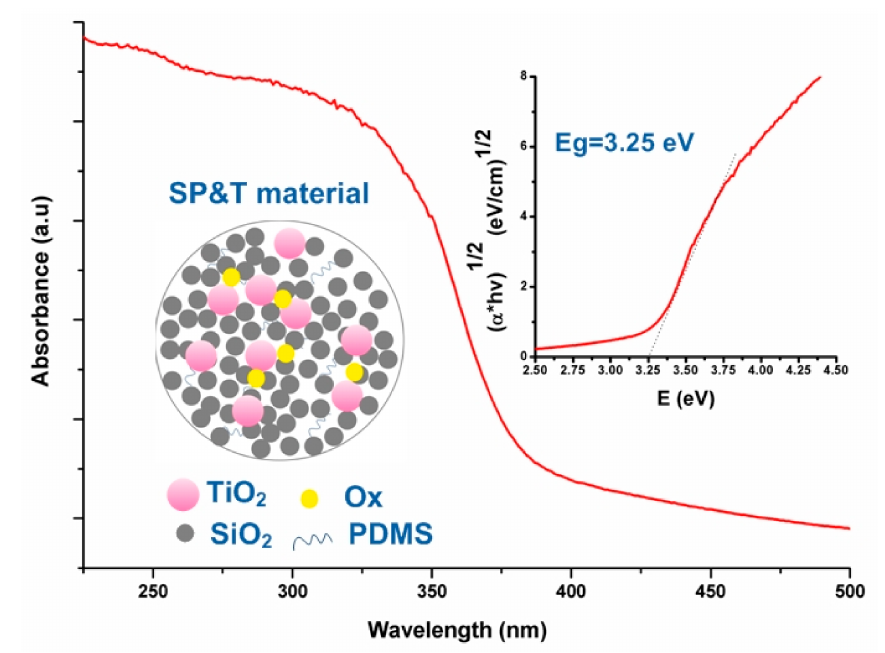
Figure 5. UV-Visible absorption spectrum and plot of (a*hv) 1/2 versus Energy for the calculation of the band-gap energy (Eg) of SP&T